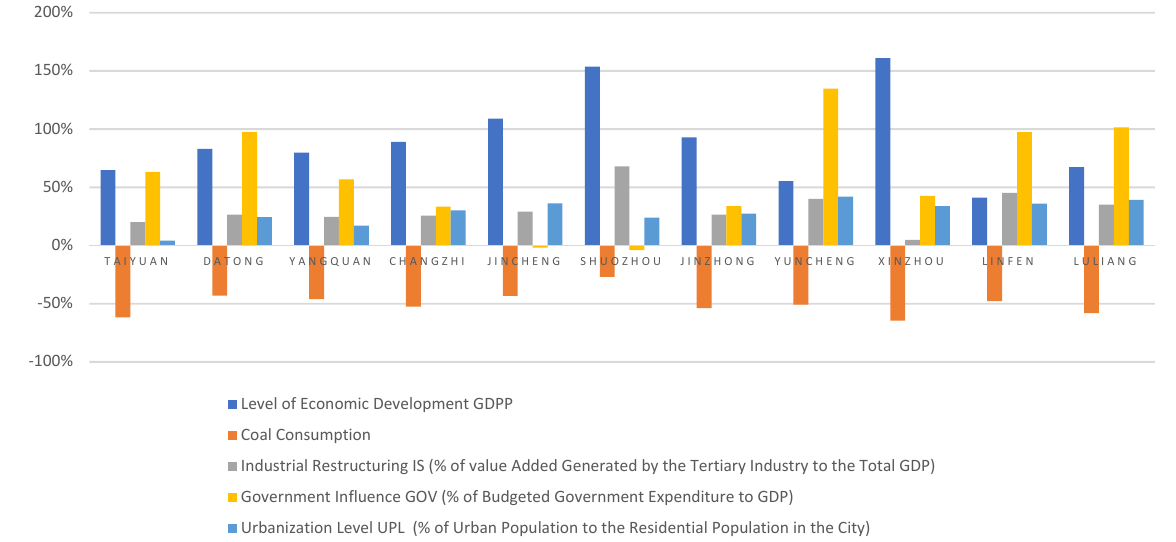
Figure 6. The percentage increase of explanatory variables such as GDPP, coal consumption CP, IS, GOV, and UPL, from 2006 to 2015.